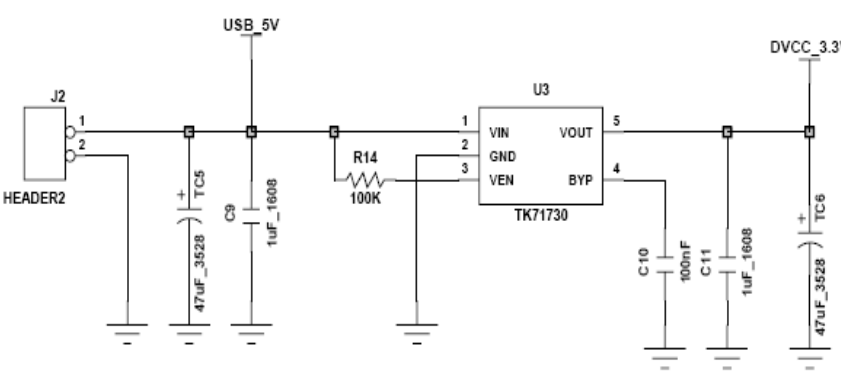
Figure 3. Power supply circuit